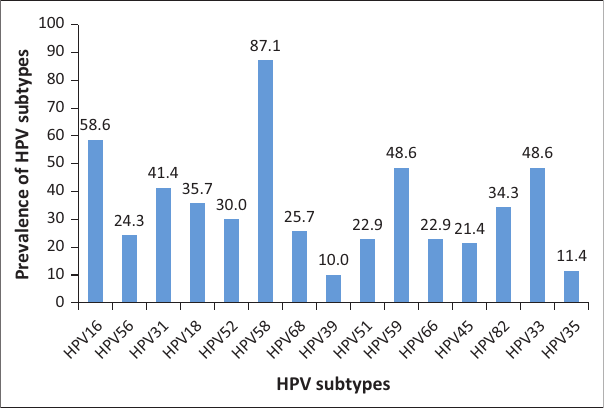
FIGURE 2: The prevalence of human papilloma virus subtypes among women living with HIV at a rural HIV clinic.